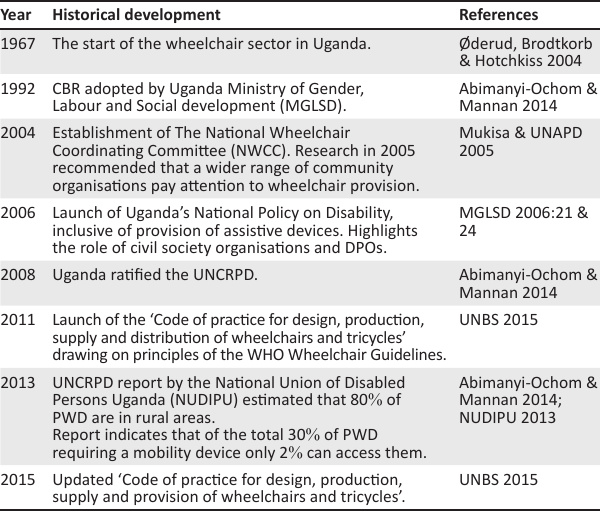
TABLE 2: Overview of key events in the wheelchair provision in